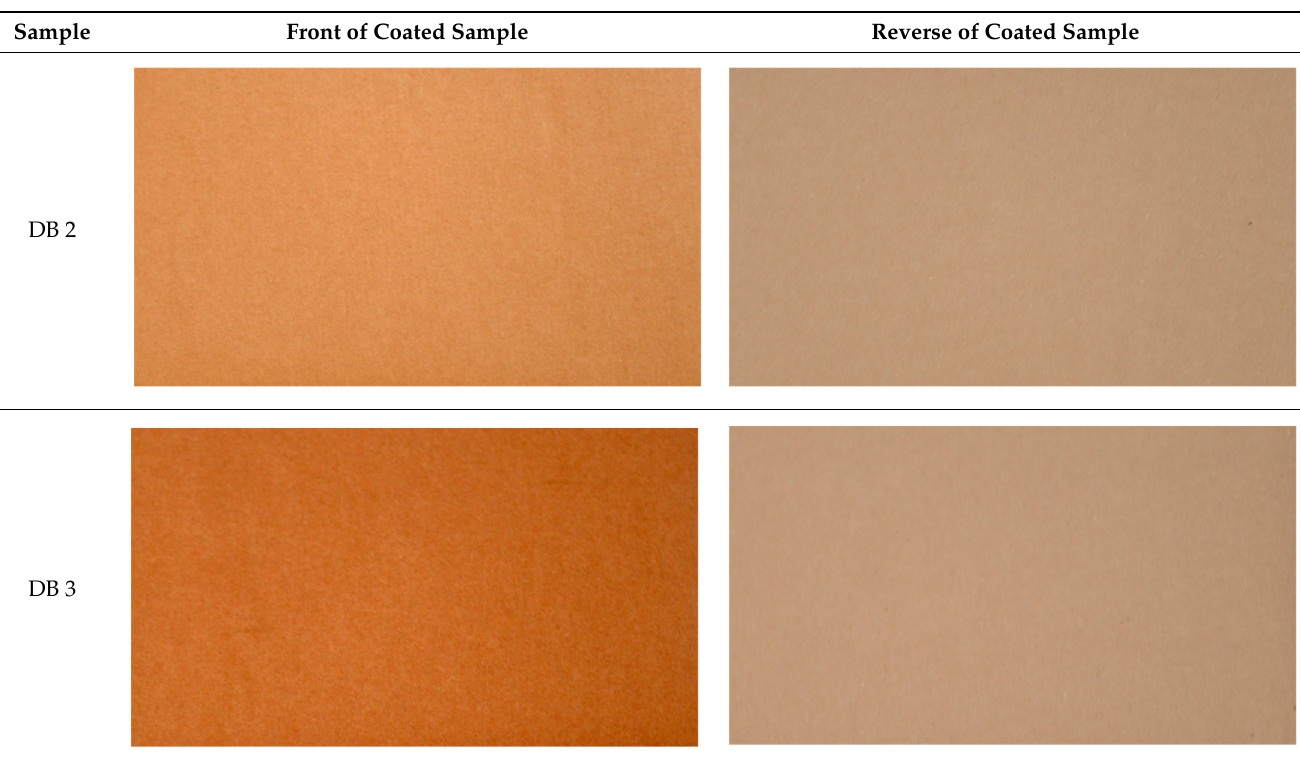
Table 5. Roughness profiles of the coated surface of the paper. DP—papers coated with paraffin- based dispersions, DB—papers coated with beeswax-based dispersions.